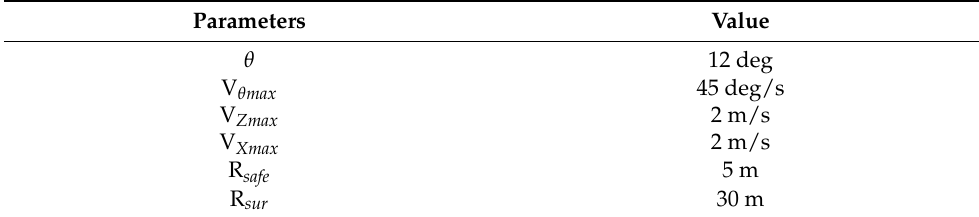
Table 3. Defined parameters for flight test.